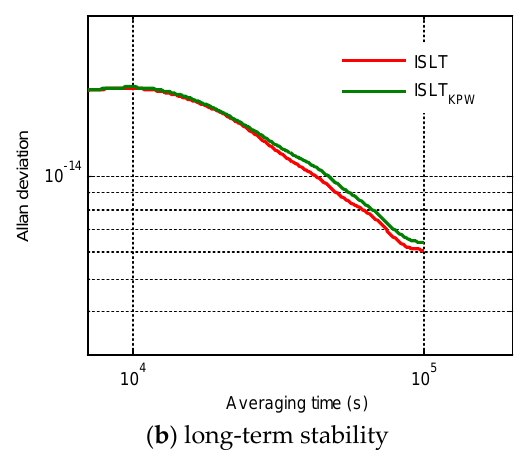
Figure 6. Frequency stability comparison of different timescales. Table 3. The ensemble of satellite clocks that kept the ISLT.